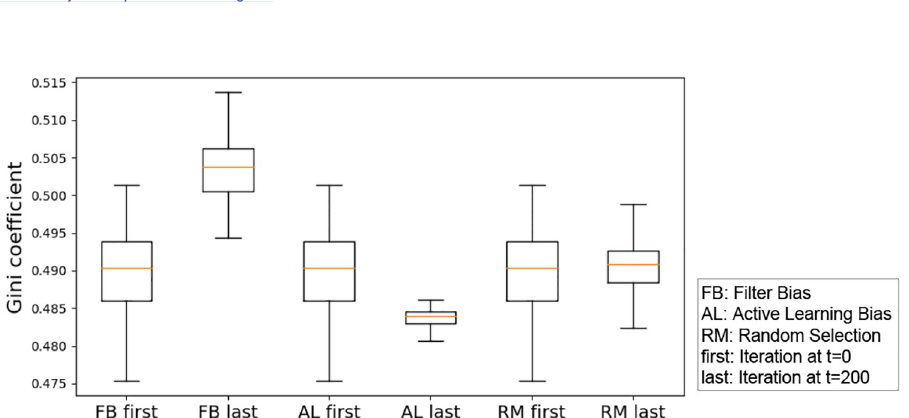
Fig 6. Box-plot of the Gini coefficient resulting from three forms of iterated algorithmic bias. An ANOVA test across these three iterated algorithmic bias forms shows that the Gini index values are significantly different. The p- value from the ANOVA test is close to 0.000 ( < 0.05), which indicates that the three iterated algorithmic bias forms have different effects on the Gini coefficient. Here, FB, AL and RM are the abbreviations of filter bias, active learning bias and random selection, respectively. The ‘first’ indicates the beginning of iteration (i.e., t = 0), while the ‘last’ means the end of iteration (i.e., t = 200). Note that we use these abbreviations in the rest of our paper.